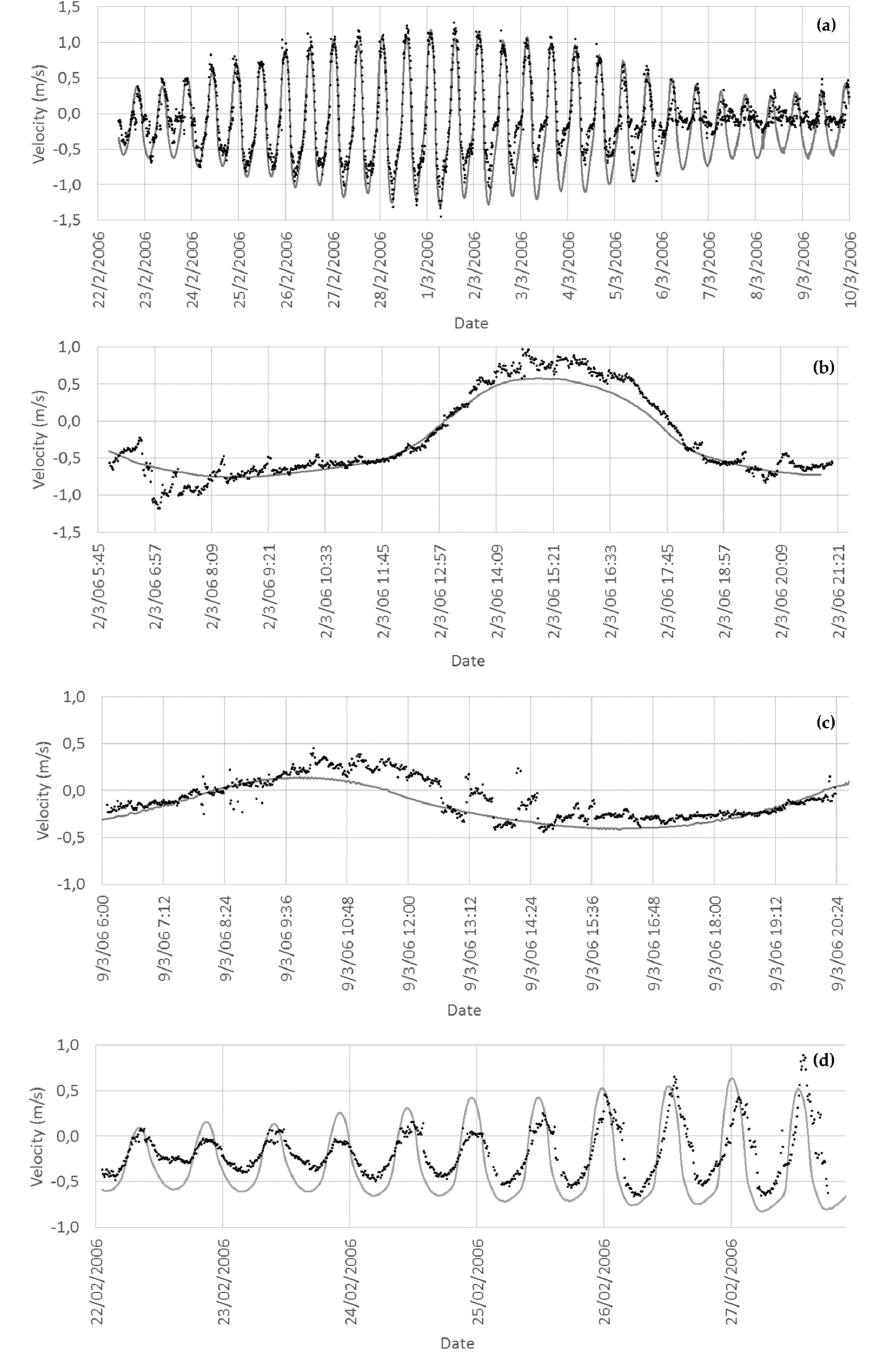
Figure 4. Current velocity (fixed depth) time series at the calibration stations. Field data (black dots) and numerical data (grey line). ( a ) Station VP1; ( b ) Station VP2 at a spring tide; ( c ) Station VP2 at a neap tide; and ( d ) Station VP4.